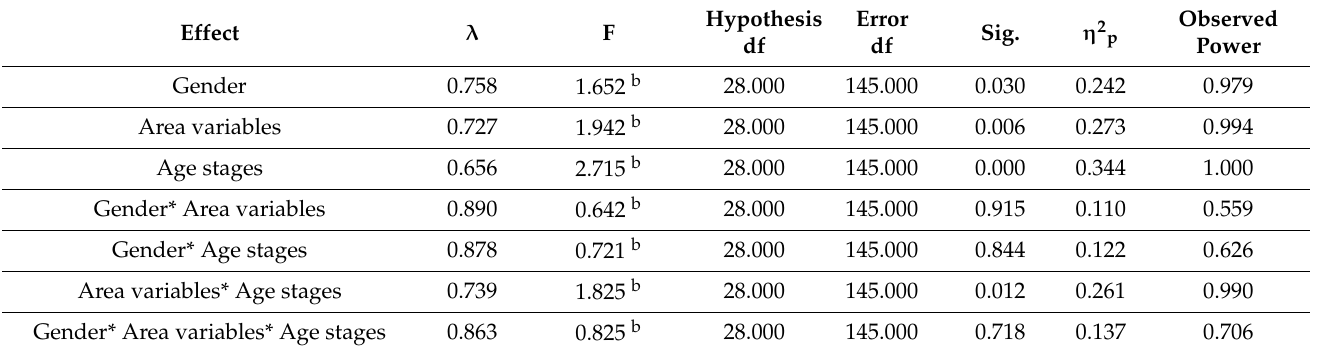
Table 4. The results of the Multivariate Tests (MANOVA)/F2(leisure limiting